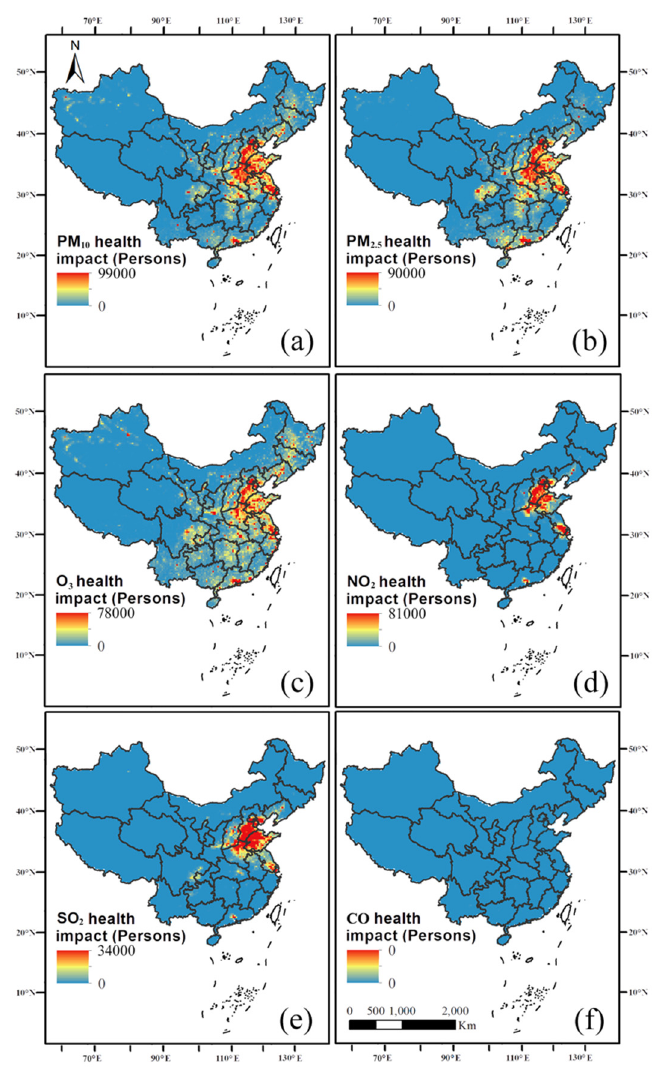
Figure 3. Spatial distribution of 10-year annual average health impact caused by each ambient pollutant in China: ( a ) PM 10 ; ( b ) PM 2.5 ; ( c ) O 3 ; ( d ) NO 2 ; ( e ) SO 2 ; ( f ) CO.